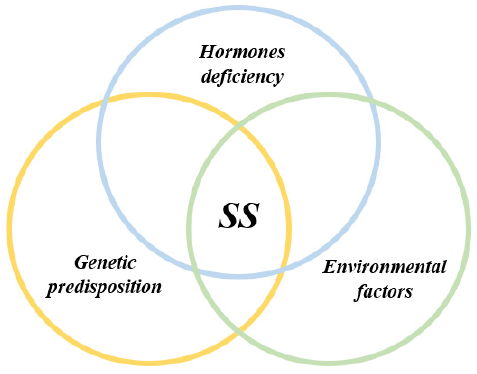
Figure 2. Factors involved in SS trigger phase.